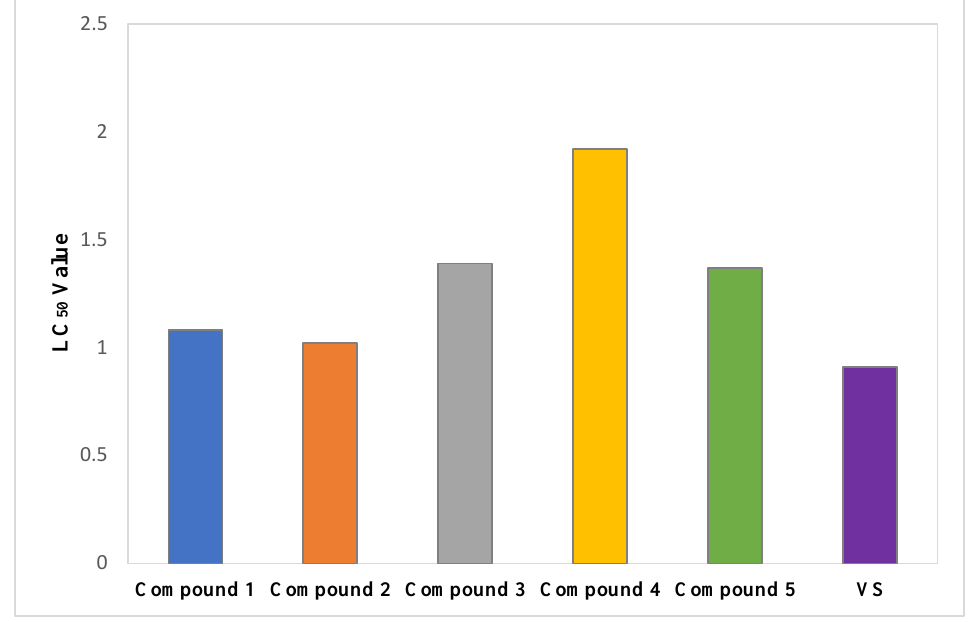
Figure 7. LC 50 values of Vincristine Sulphate (VS) and isolated phytochemicals of Glycosmis cyanocarpa 2.4. Effect of Isolated Phytochemicals from G. cyanocarpa on Disc Diffusion Assay